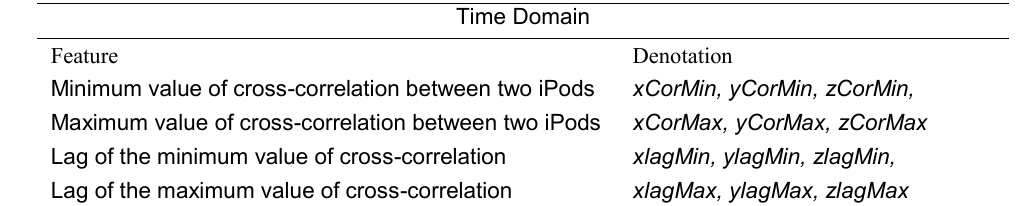
Table 2. Features and denotations in Feature Set II.